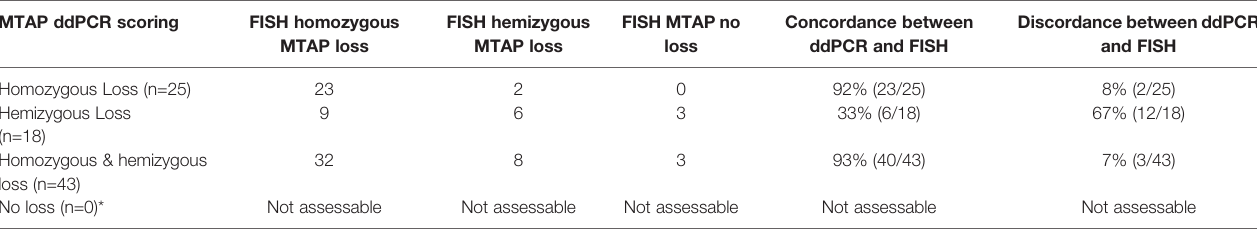
TABLE 8A | Comparison of droplet digital PCR (ddPCR) and fl uorescence in situ hybridization (FISH) results for detecting methylthioadenosine phosphorylase (MTAP) homozygous and hemizygous loss. (details in Supplementary Table 8 ).